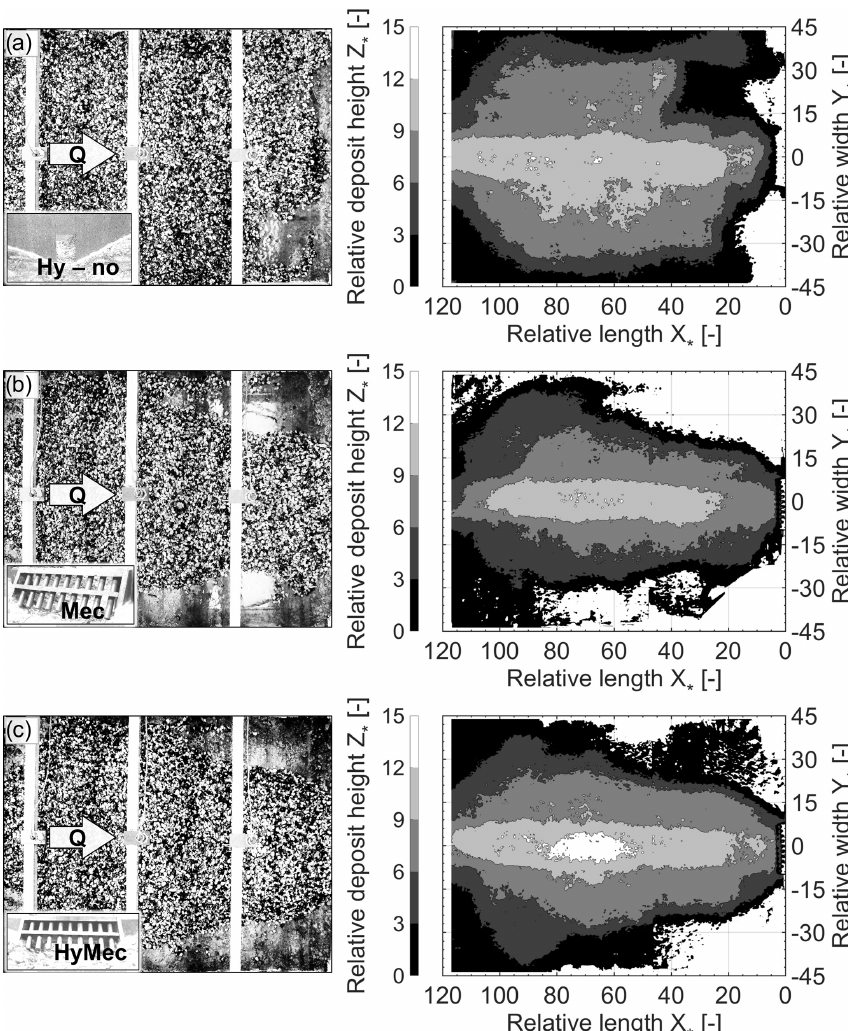
Figure 10. Deposition patterns at the end of the hydrograph tests; left column: top view pictures; right column: bathymetric records, (a) in case Hy-no ( α test), with non-overflowed hydraulic barrier; (b) in case Mec ( α test), with bar screen for mechanical control only; and (c) case HyMec (test a 3 α) , with combined hydraulic barrier and upstream superposed bar